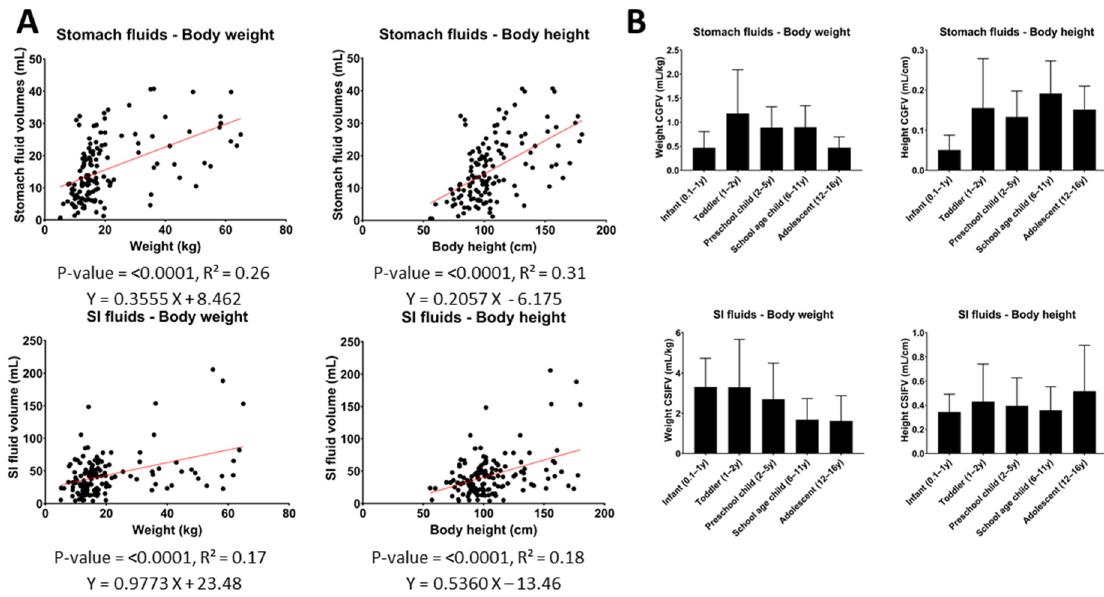
Figure 4. ( A ) Correlations between gastric or SI fluid volumes and body weight and height. ( B ) Weight- or height-normalized gastric/SI fluid volumes per pediatric subpopulation. (Two-tailed p -value of correlation, R 2 = coefficient of determination, CGFV = corrected gastric fluid volume, CSIFV = corrected SI fluid volumes, y = year) .